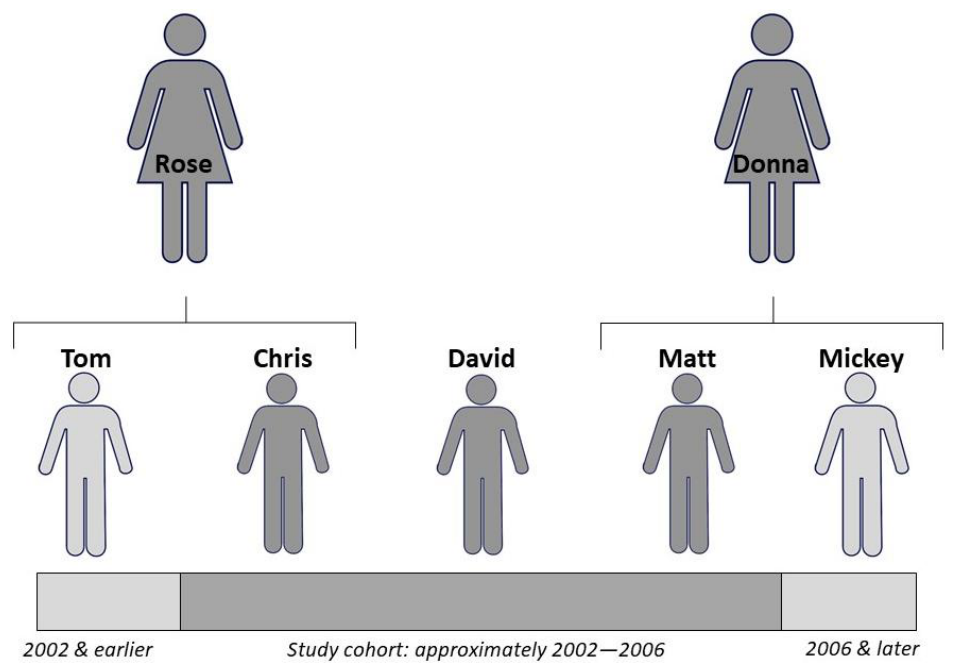
Figure 1. Research participants were selected to represent a timeline of the creek play to demonstrate the uniqueness of the boys’ experience of autonomous exploration [49] .